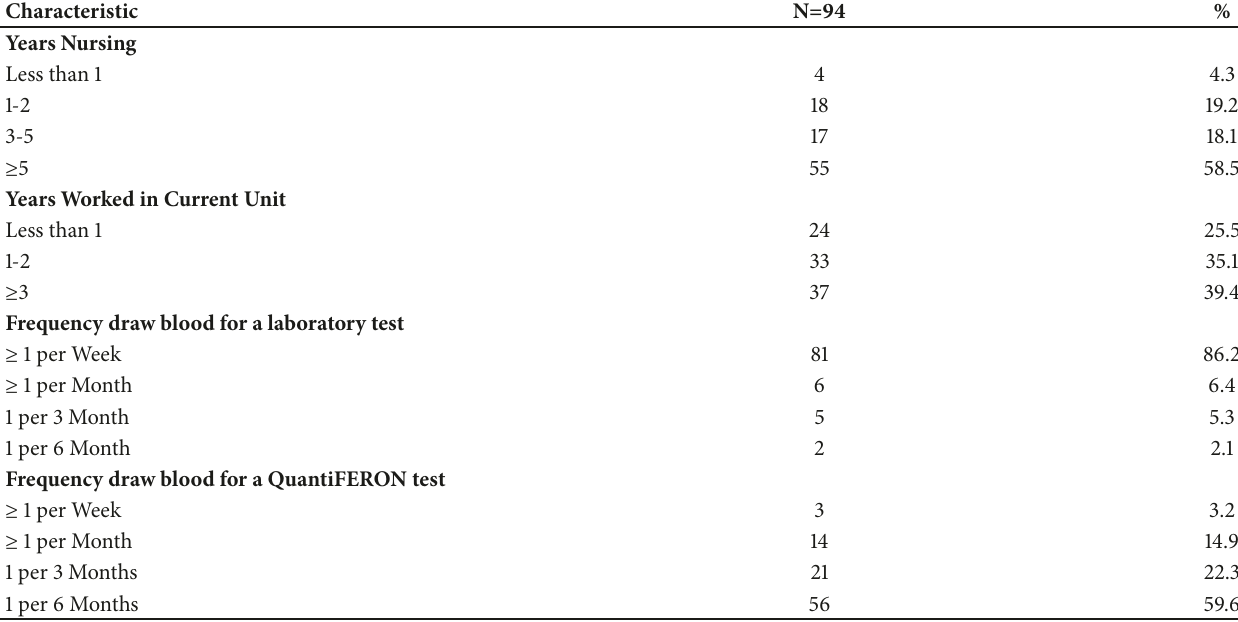
Table 2: Characteristics of nurses that completed the QFT-G education